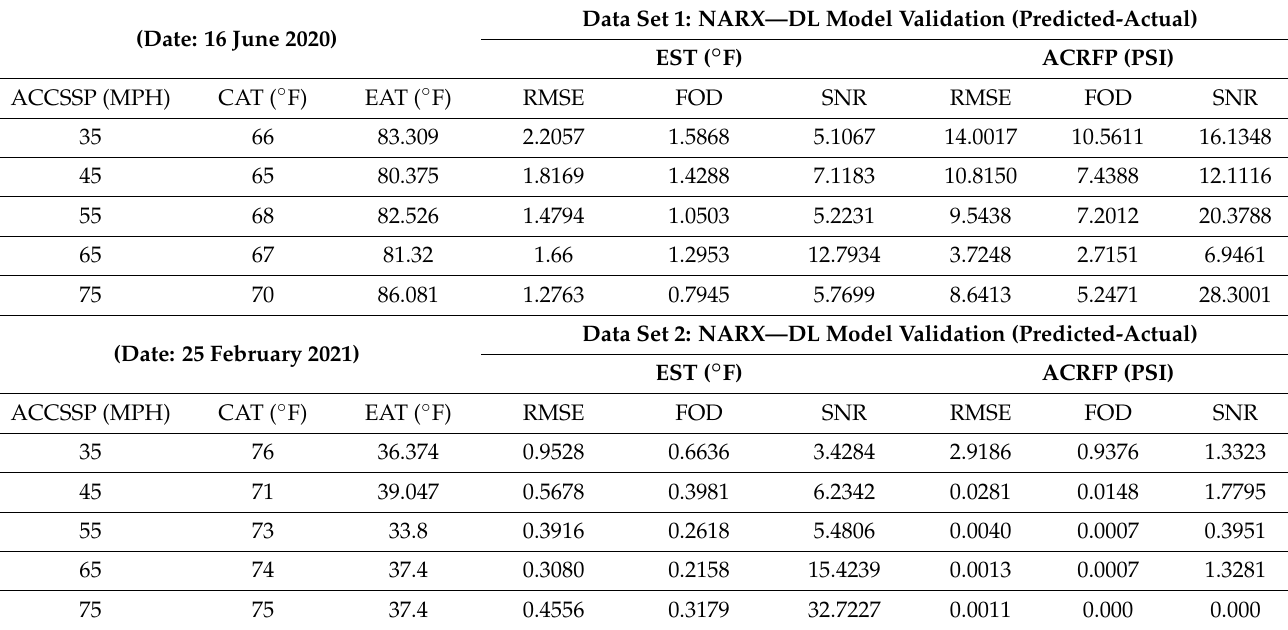
Table 7. NARX Model Performance—ACC Speeds [35 75]